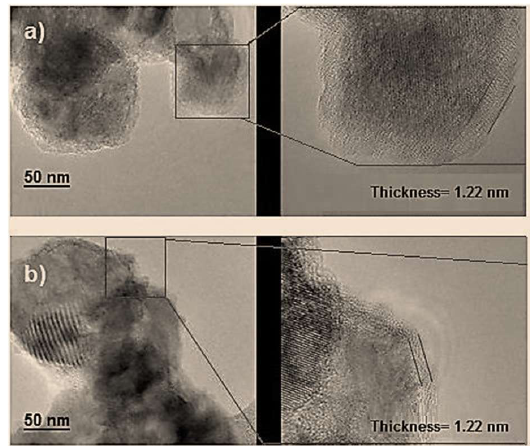
Figure 4. Transmission electron microscopy micrograph. Malotodextrine-modified ZnO-NPs with ( a ) spherical and ( b ) hexagonal morphology.